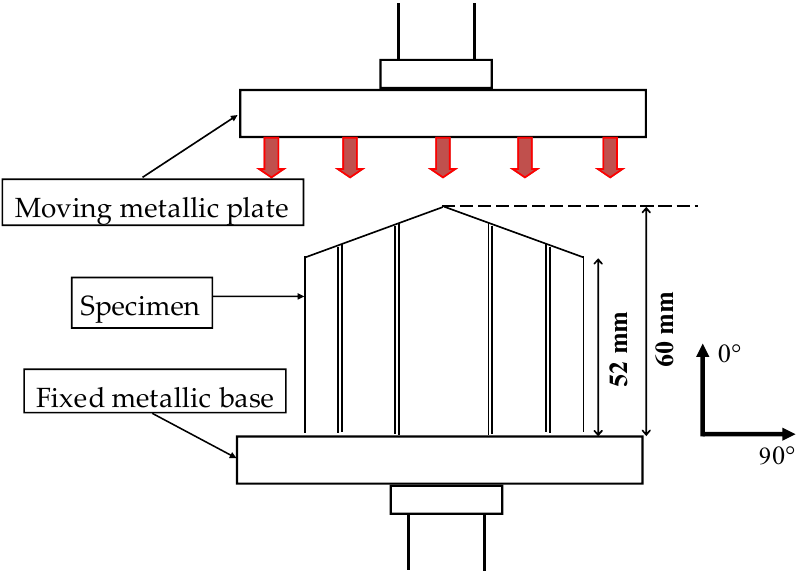
Figure 4. A schematic diagram of the experimental setup.